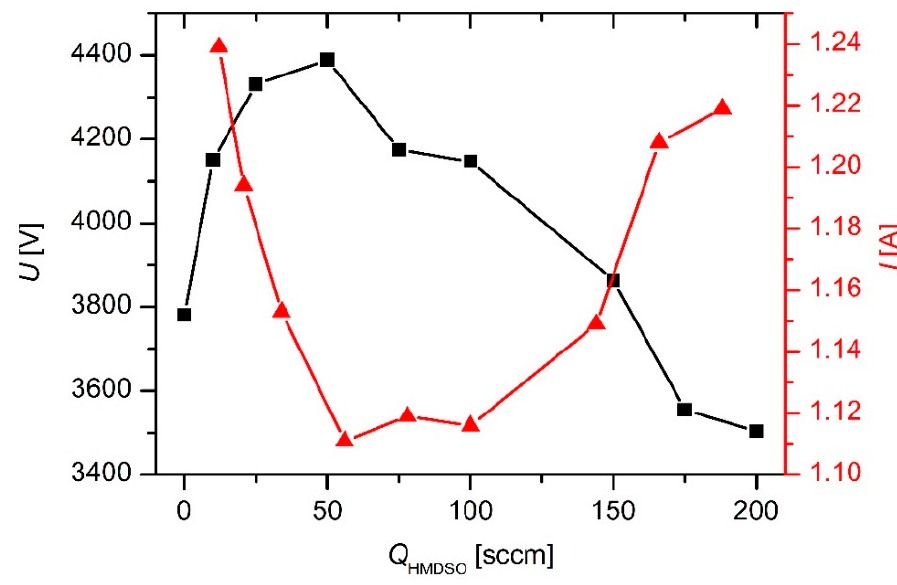
Figure 3. The voltage (left-hand y -axis) and current (right-hand y -axis) versus the HMDSO flow.